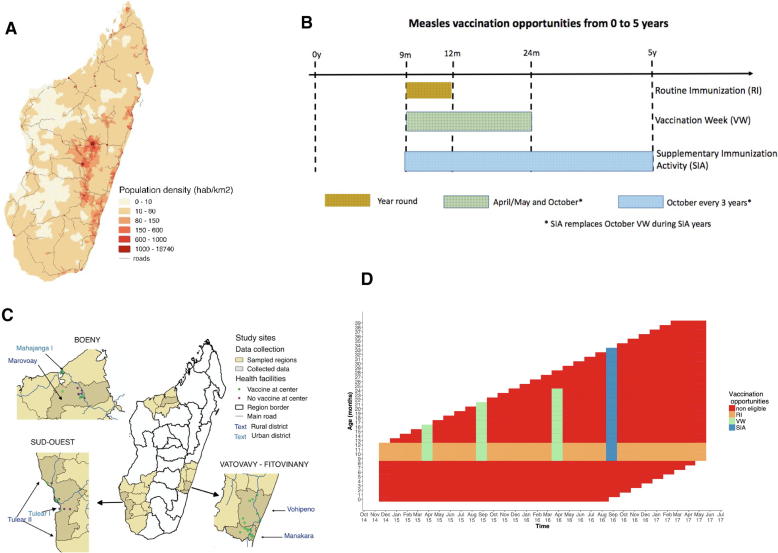
The study site and measles vaccination schedule in Madagascar. (A) Madagascar’s population density is highly variable, with few densely populated areas. (B) There are three measles vaccination mechanisms in Madagascar: routine immunization (RI), biannual vaccination weeks (VW), and Supplementary Immunization Activities (SIA) every three years. The eligible age range also varies by each program (RI: 9–12 months, VW: 9–24 months, and SIA: 0–59 months). (C) Vaccination cards and healthcare worker surveys were undertaken at 49 health centers from 6 districts throughout 3 regions across the country (Materials and Methods), yielding 15,951 cards digitized and 49 healthcare workers surveyed. (D) Differences in timing and age eligibility for vaccination leave children eligible for different vaccination activities throughout the year; and this characterization is used to extrapolate how vaccination coverage and its timeliness vary.